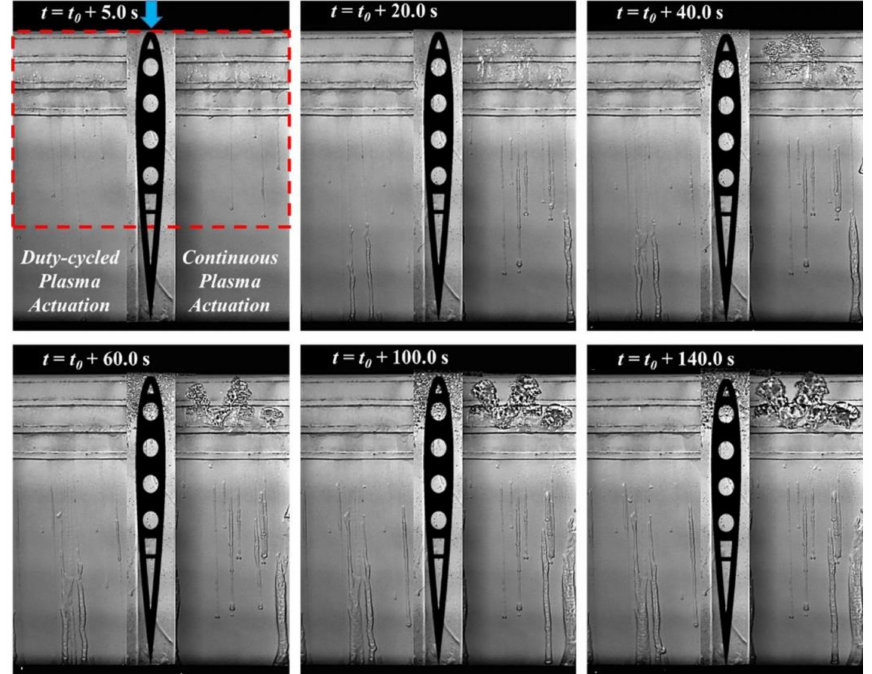
Figure 20. Ice accretion over the airfoil in duty-cycled plasma actuation (left side) versus conventional continuous plasma actuation (right side) (adapted from Liu et al. [183] with the permission of